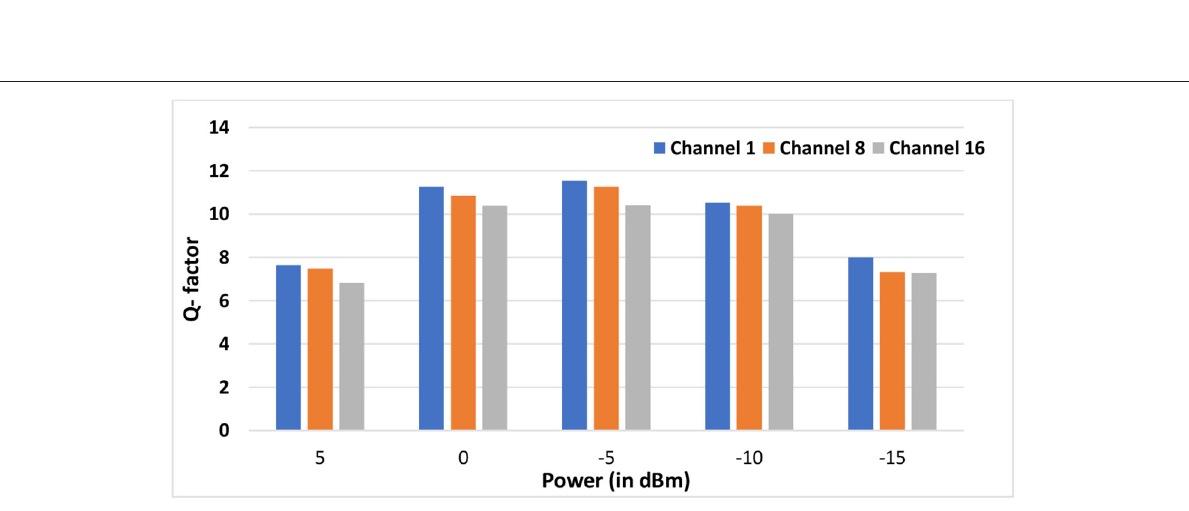
FIGURE 8 | The eye diagrams for the conventional WDM-based RoF system for 100 GHz channel spacing. (A) The eye diagrams at channels 1, 8, and 16 at − 5 dBm input power. (B) The eye diagrams at channels 1, 8, and 16 at − 15 dBm input power.